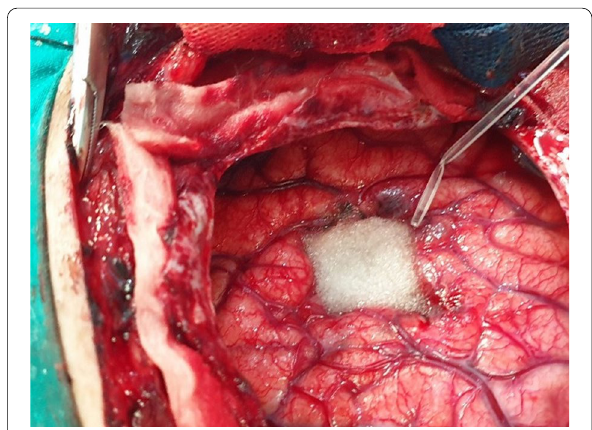
Fig. 1 Sealing fibrin adhesive glue at the sits of cortical